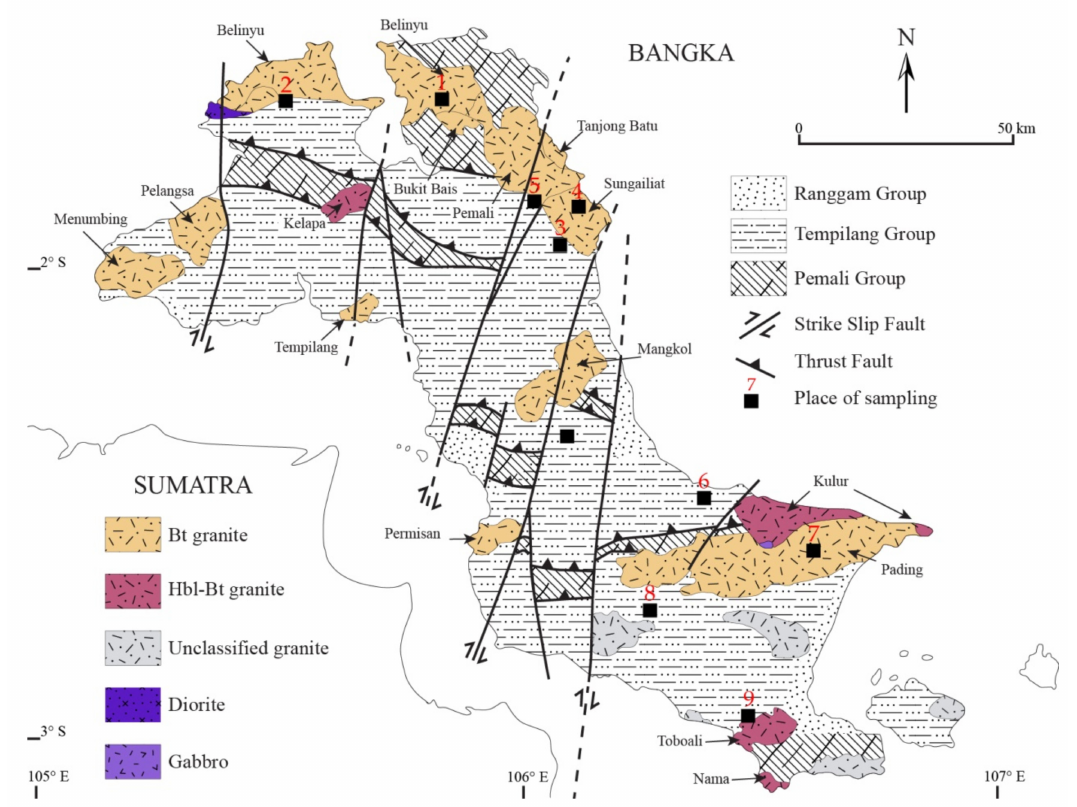
Figure 1. Geological map of Bangka Island (modified from